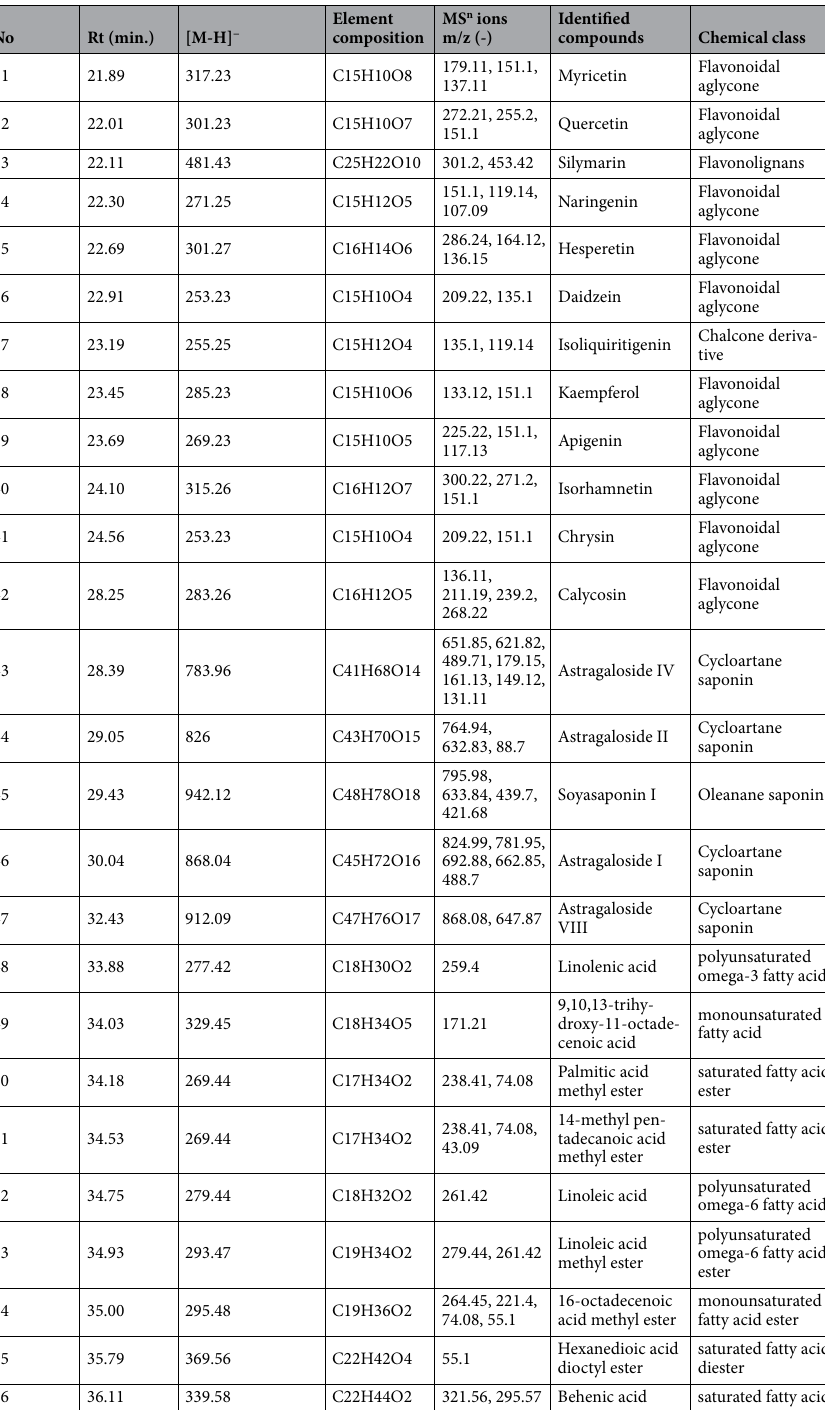
Table 1. Metabolites identified in Astragalus samples extracts using UPLC-MS in negative ionization